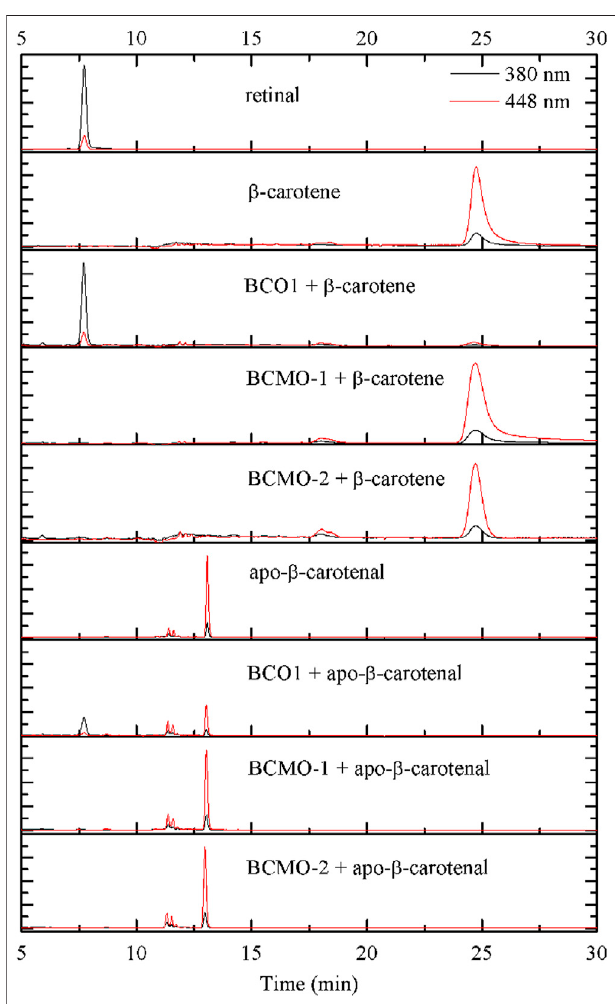
FIGURE 7 | BCMO-1 and BCMO-2 do not cleave β -carotene or apo- β - carotenal. Chromatograms were recorded at 380 nm (black pro fi le) and 448 nm (red pro fi le). Separation of the substrate and product was achieved withpropan-2-ol/acetonitrile/water(72/18/10,v/v/v)fromtime 5 – 30 min of HPLC analysis (described under Materials and